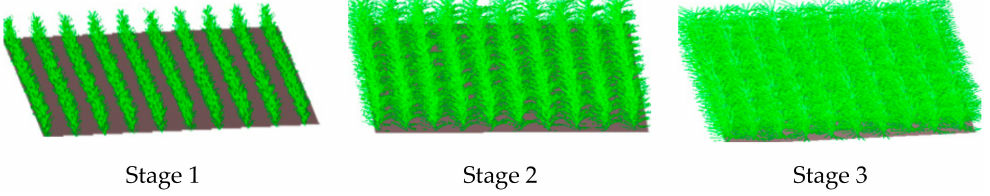
Figure 3. Scenes of three growth stages. Table 1. Row structure configuration of simulation scene for the three growth